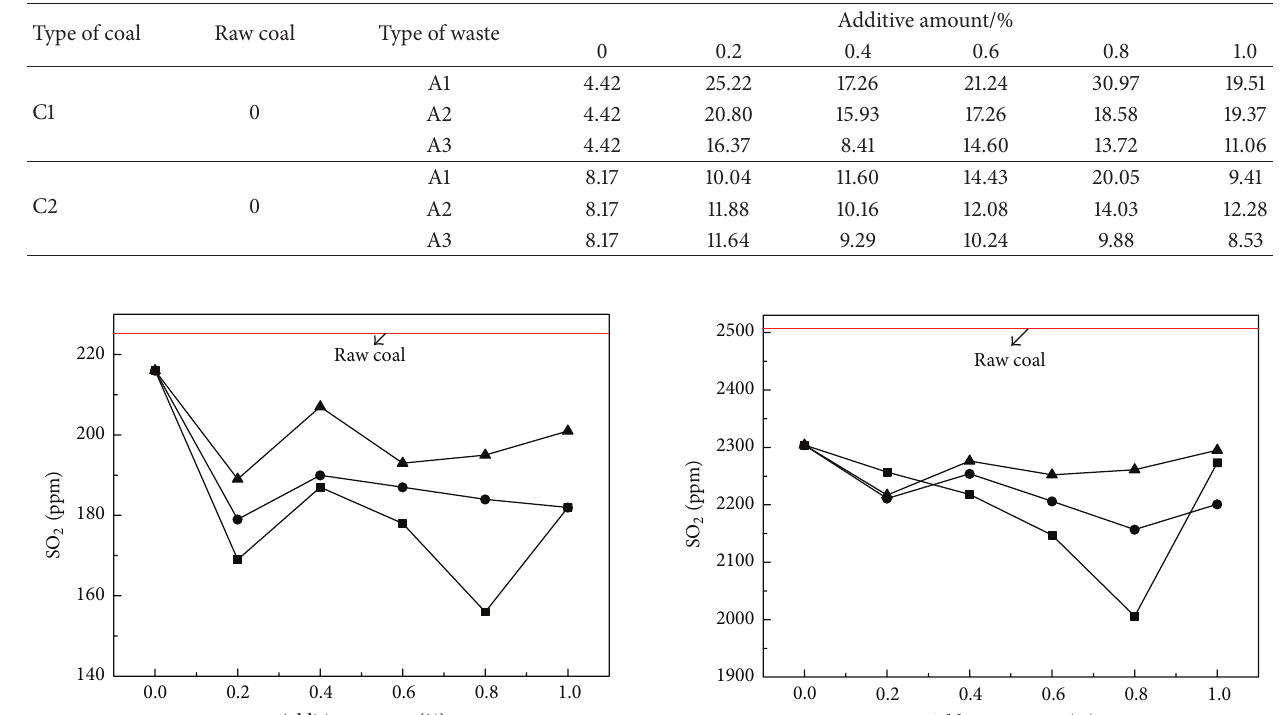
Table 4: The effect of different additives on desulfurization efficiency of C1 and C2 (%).